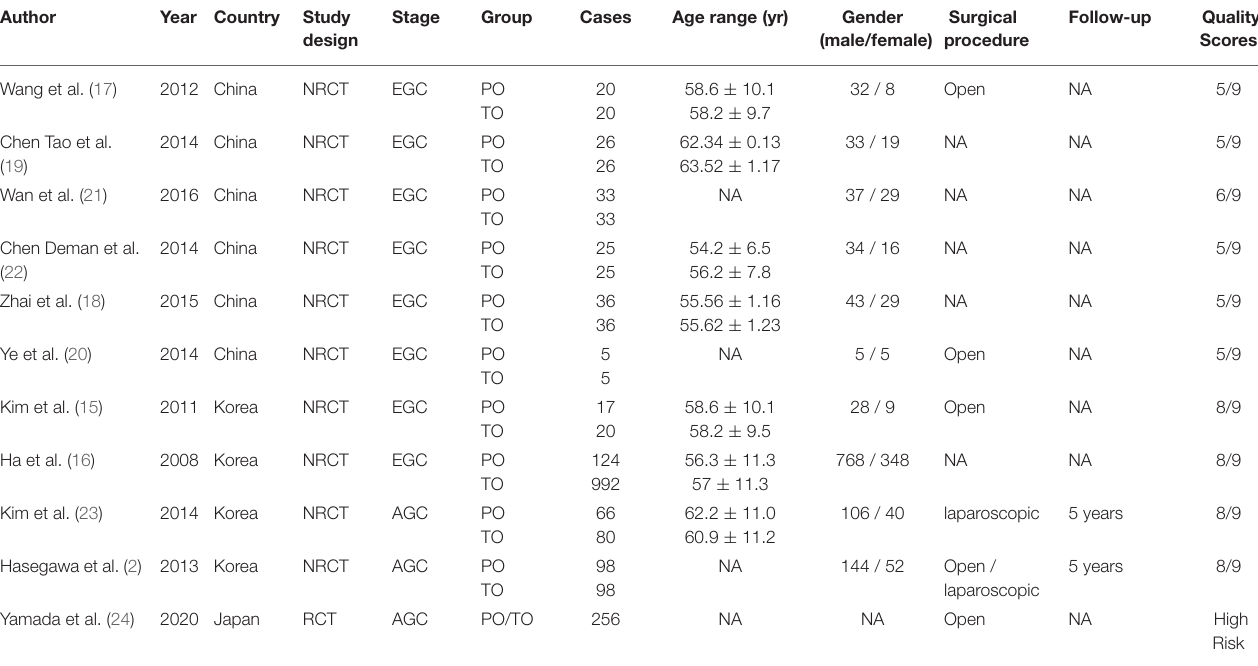
TABLE 1 | Characteristics of patients between total omentectomy and partial omentectomy